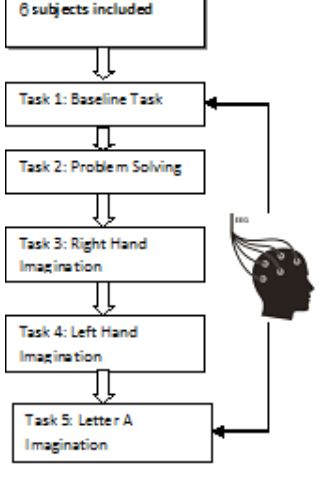
Figure 1. Order of the experiments